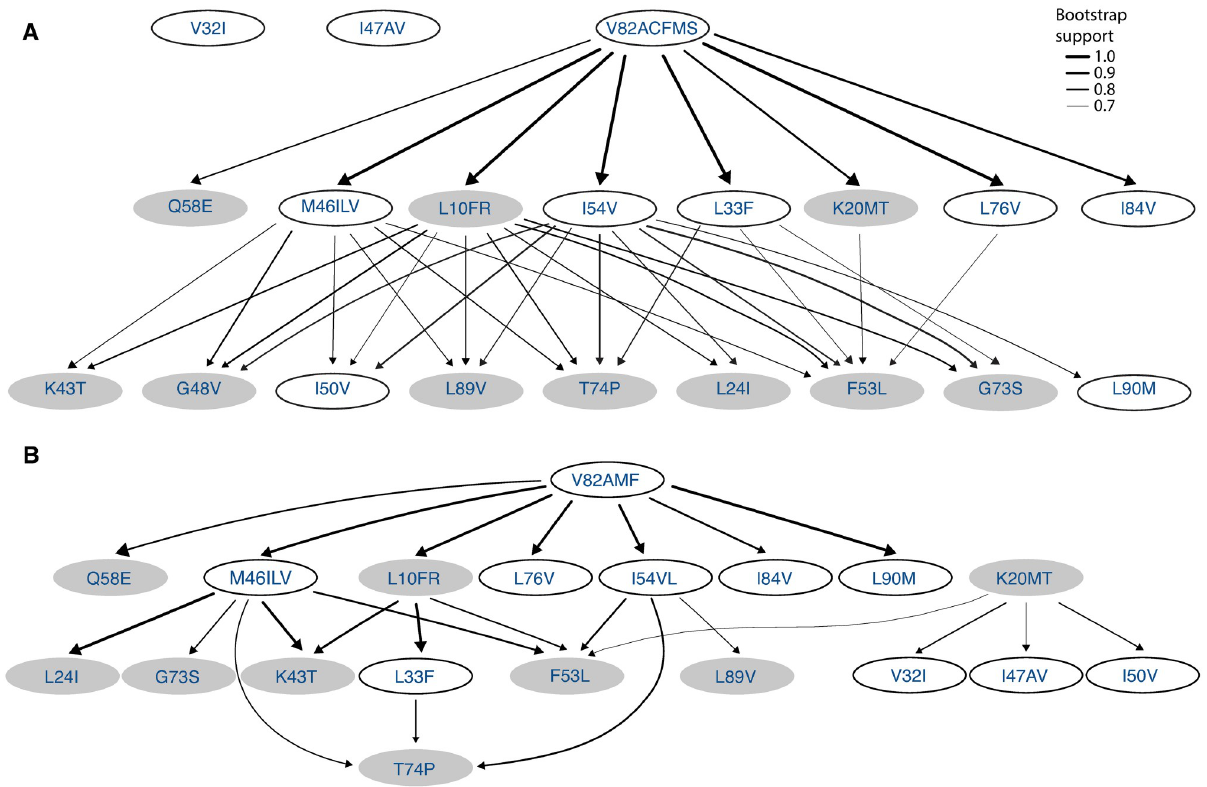
Fig 3. Consensus posets for lopinavir resistance for two different HIV-1 subtype C data sets. Shown are the consensus poset for A the South African cohort and B for the remaining HIV-1 subtype C sequences retrieved from the HIVDB. Nodes in the network correspond to amino acid changes in the HIV-1 protease, where mutations at the same locus are grouped together in one event. Only edges with a bootstrap support greater than 0.7 are shown and the edge thickness indicates the bootstrap support. Nodes with white background show residues with at least one major PI mutation.